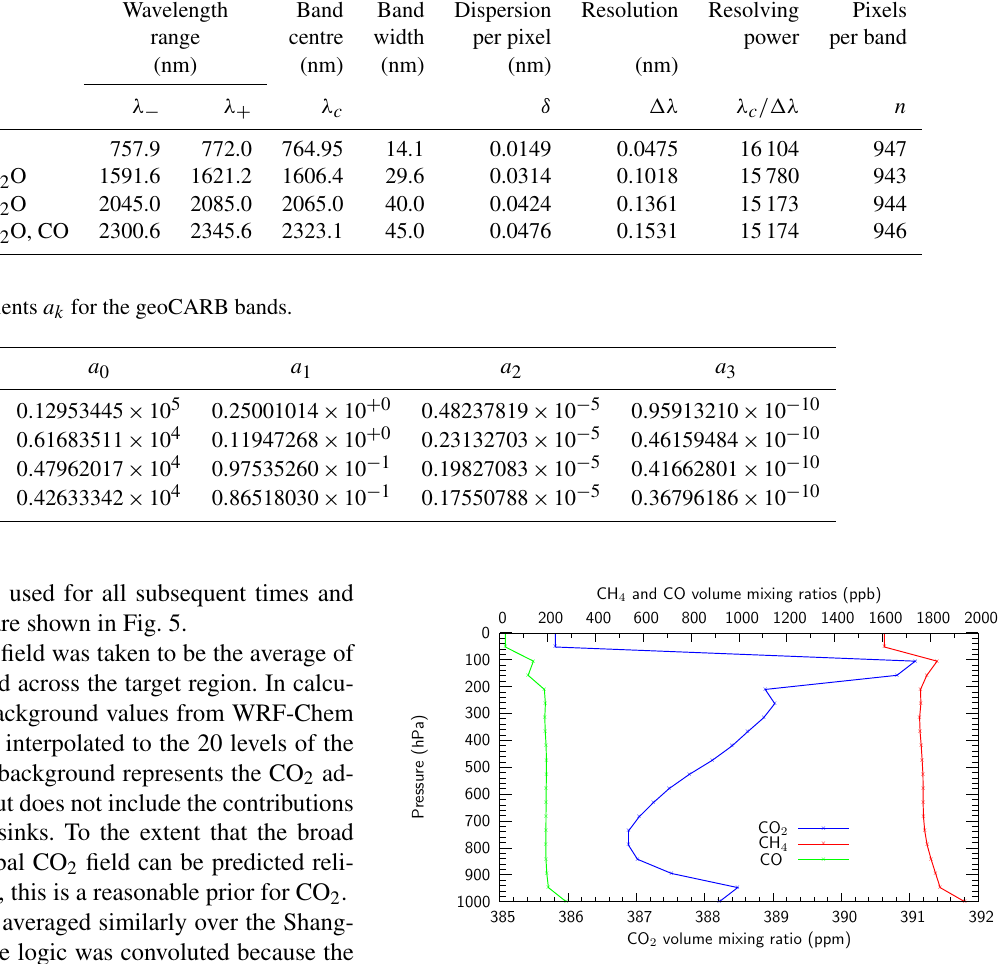
Table 4. Spectral ranges and resolutions of the geoCARB bands for the baseline configuration. The bands at 1.606 and 2.065µm are referred to in the text as the “weak” and “strong” CO 2 bands. Band Gases Wavelength Band Band Dispersion Resolution Resolving Pixels range centre per pixel power